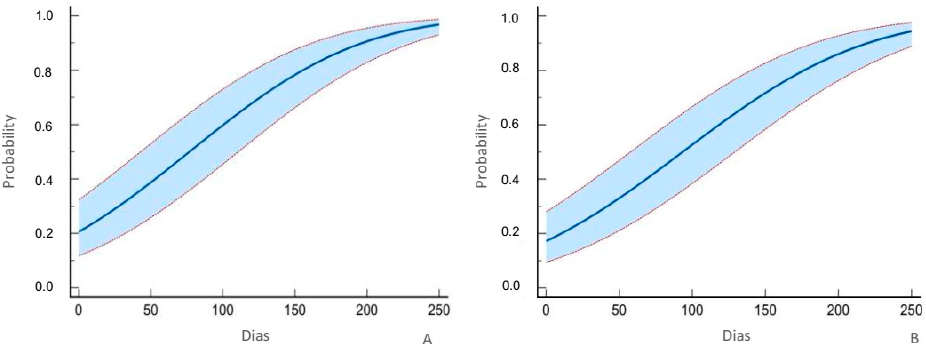
Figure 2. Probit regression of chestnut weevil, curculio elephas (Gyllenhal) in T1 ( A ) and T2 ( B ) modality.